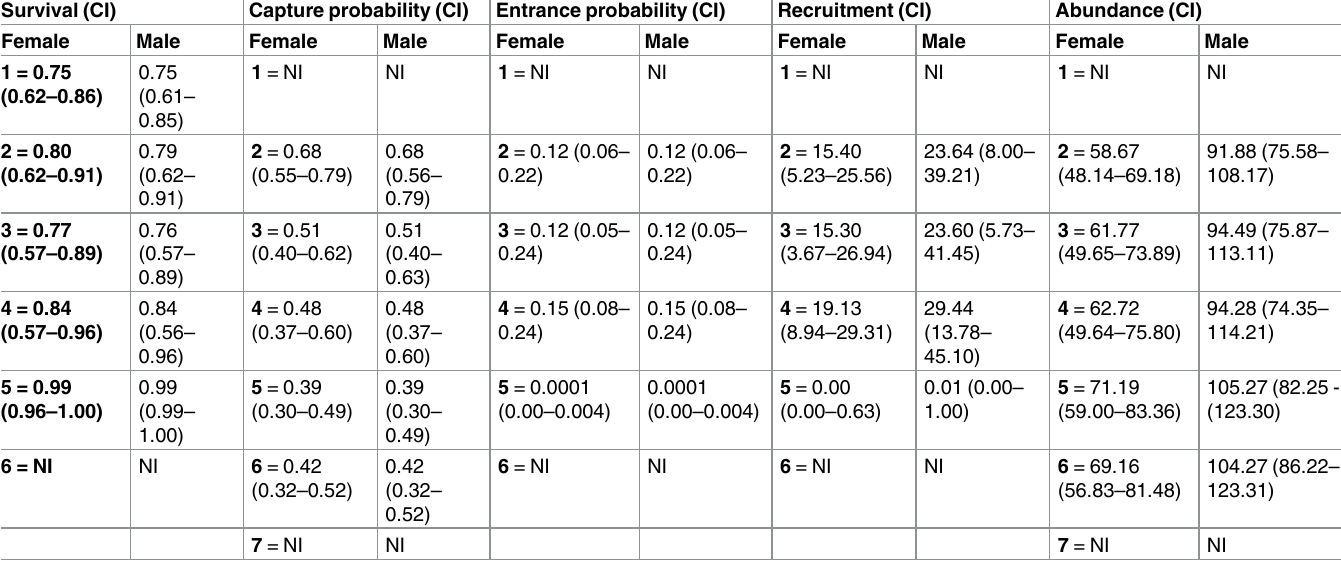
Table 3. Estimatesfor sex.